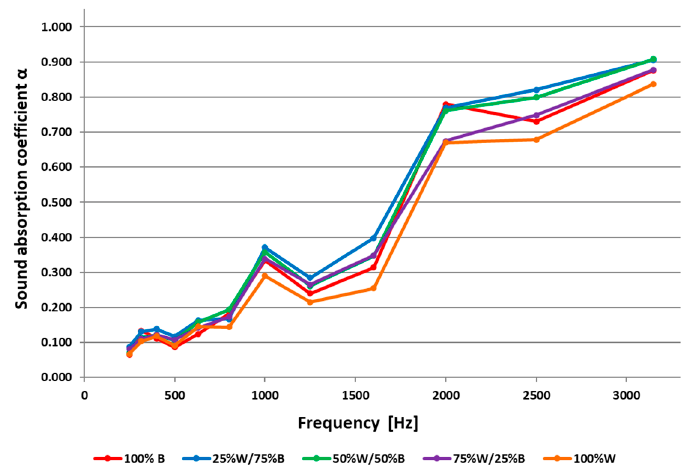
Figure 2. Sound absorption coefficient, α .